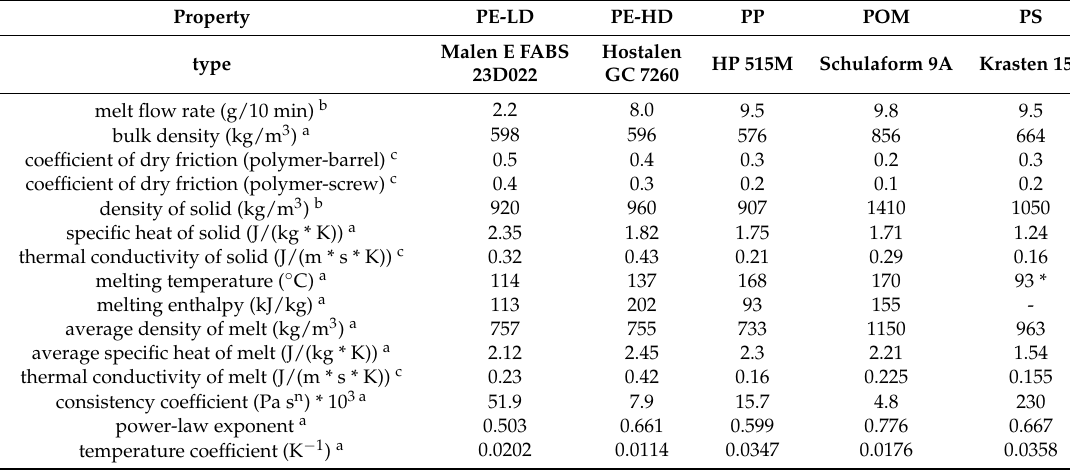
Table 2. Material data for tested